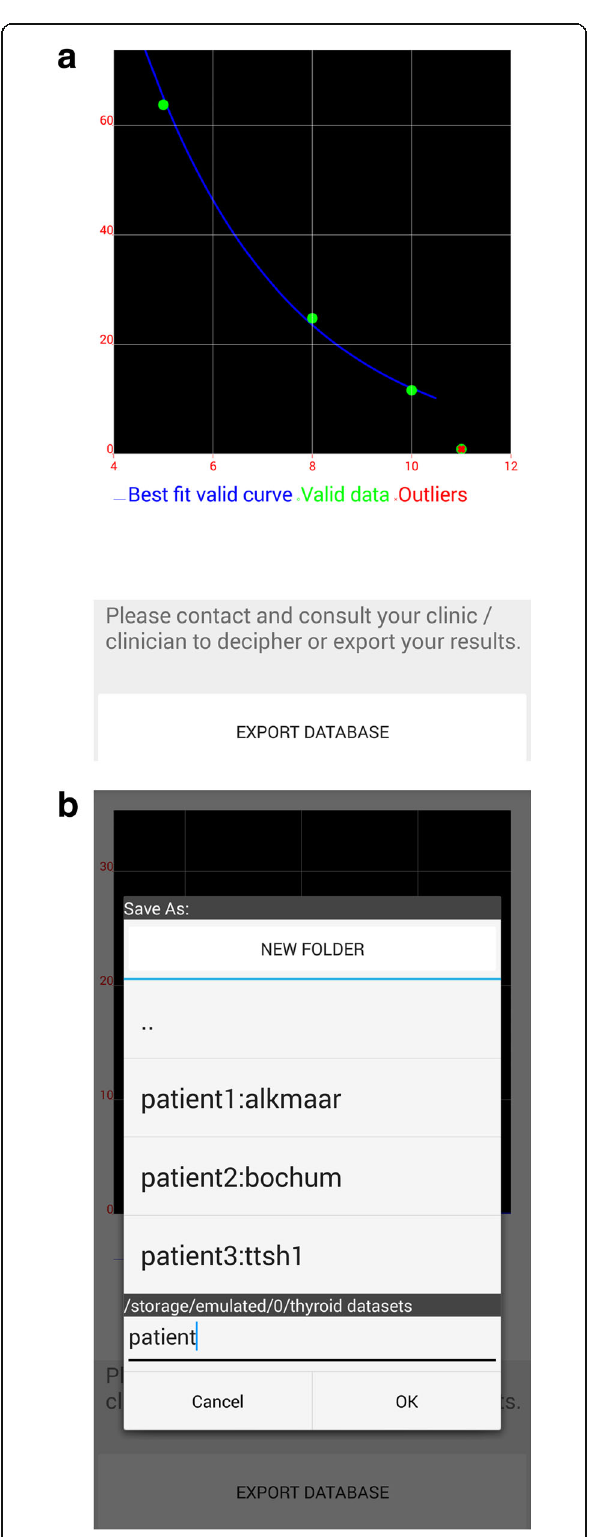
Fig. 3 Thyroid-SPOT Doctor App ’ s Patient Selection. a Importing of patient details. b The entry tables of the blood test